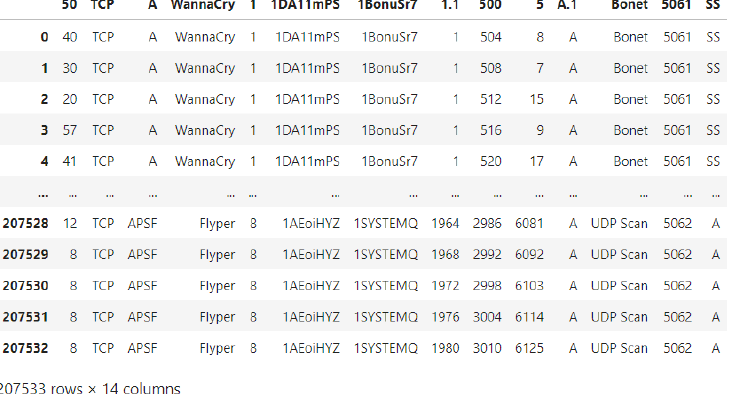
Figure 4. The Dataset